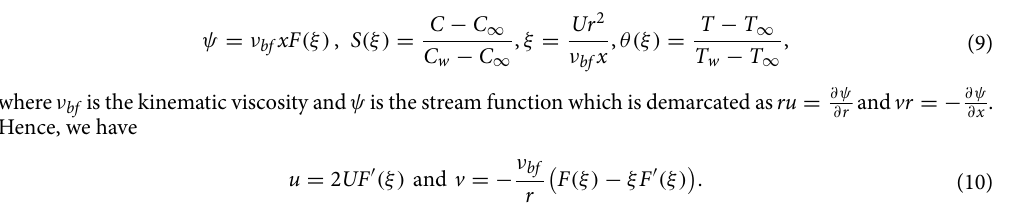
a in Eq. (9), which designates the shape or object and proper size of the variable In addition, by putting ξ = R ( x ) , the appropriate surface may be represented as R ( x ) thickness, r =